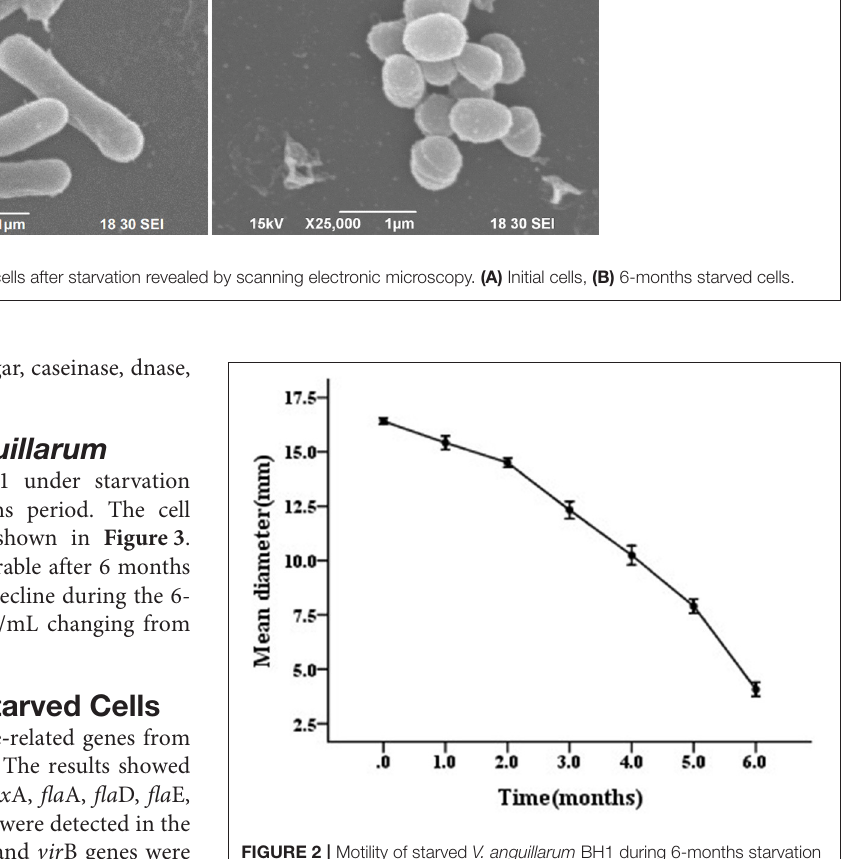
FIGURE 2 | Motility of starved V. anguillarum BH1 during 6-months starvation at 28 ◦ C. Error bars: ± SD.